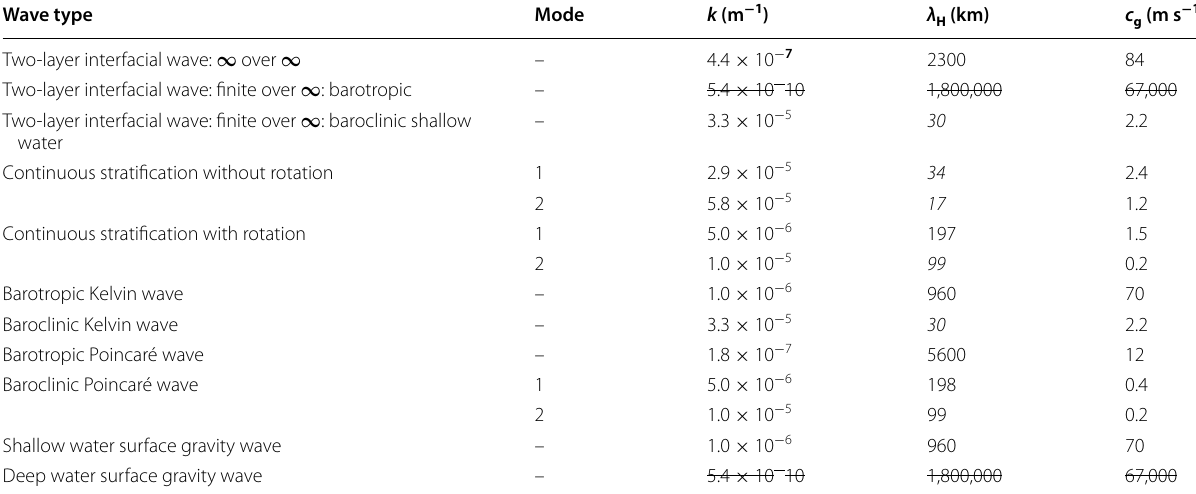
constituent (period 23.94 h; 1 =